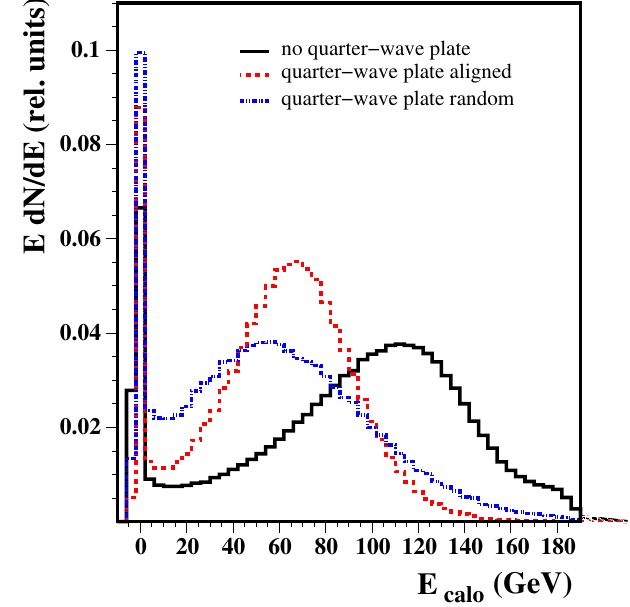
FIG. 18. (Color) Power spectrum of the photon beam measured in the calorimeter. Without the quarter wave plate crystal, the predicted CB spectrum is observed (solid line). With the aligned quarter wave plate inserted, the spectrum shifts to lower energies (dashed line). With the quarter wave plate in random orientation, we see more spread in the shifted spectrum.